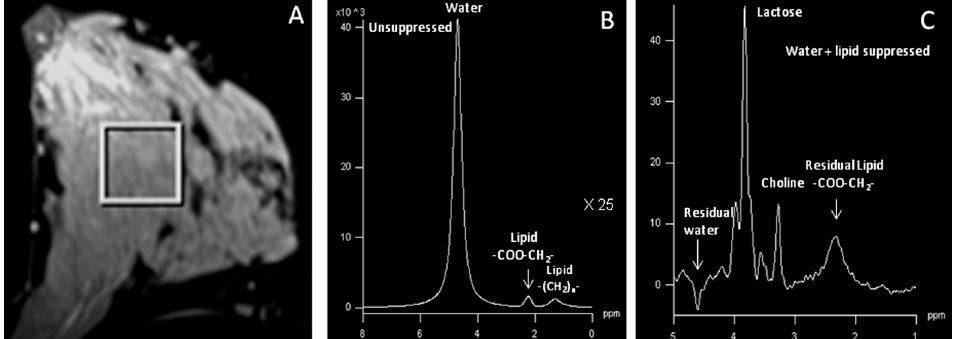
Figure 4. ( A ) T2-weighted, fat-suppressed axial image from the normal breast tissue of a lactating woman volunteer showing a voxel location of size 20 × 20 × 20 mm 3 ; ( B ) corresponding 1 H MR spectrum obtained without water and lipid suppression showing the water and lipid peaks; ( C ) 1 H MR spectrum obtained with water and lipid suppression showing the residual water and lipid along with the tCho and the lactose peaks (Reproduced with permission from John Wiley and Sons from Reference [55]).